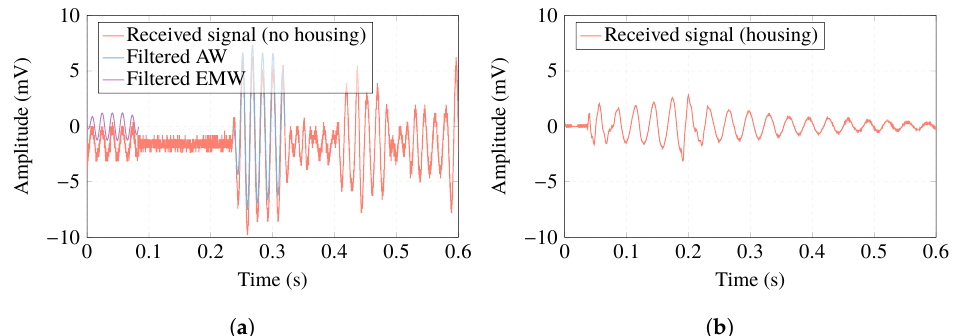
Figure 6. ( a ) Signal received in the process of emission-reception in the piezoelectric ceramic free in water (electromagnetic wave (EMW) in red, acoustic wave (AW) in blue); ( b ) example of the acoustic signal received by housing